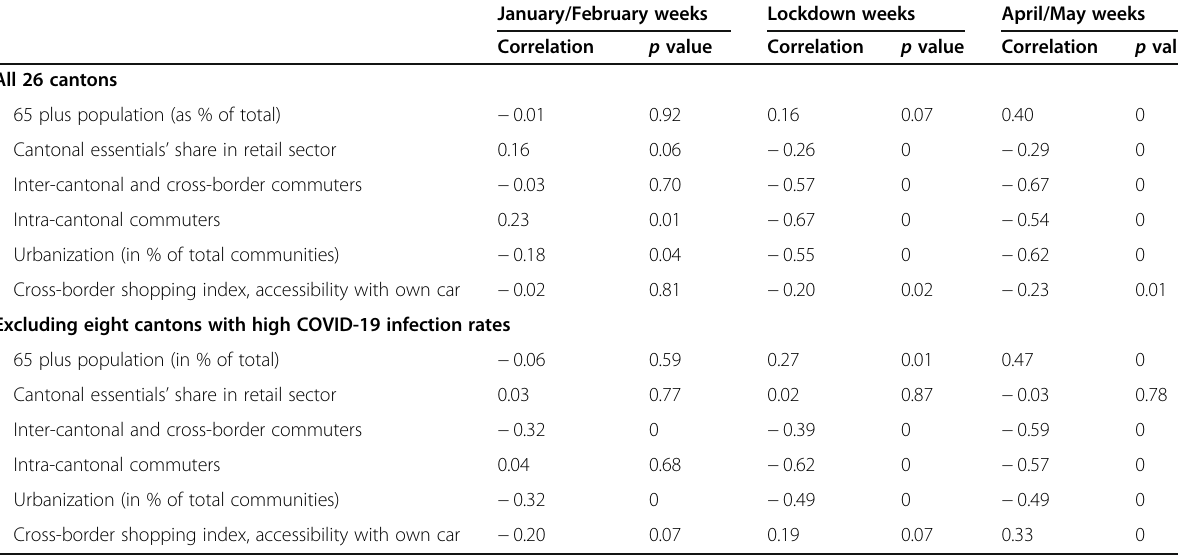
Table 2 Correlations of excess domestic card-present retail payments with selected indicators across pre-lockdown, lockdown, and post-lockdown periods. Source: Own calculations, Worldline/SPS,